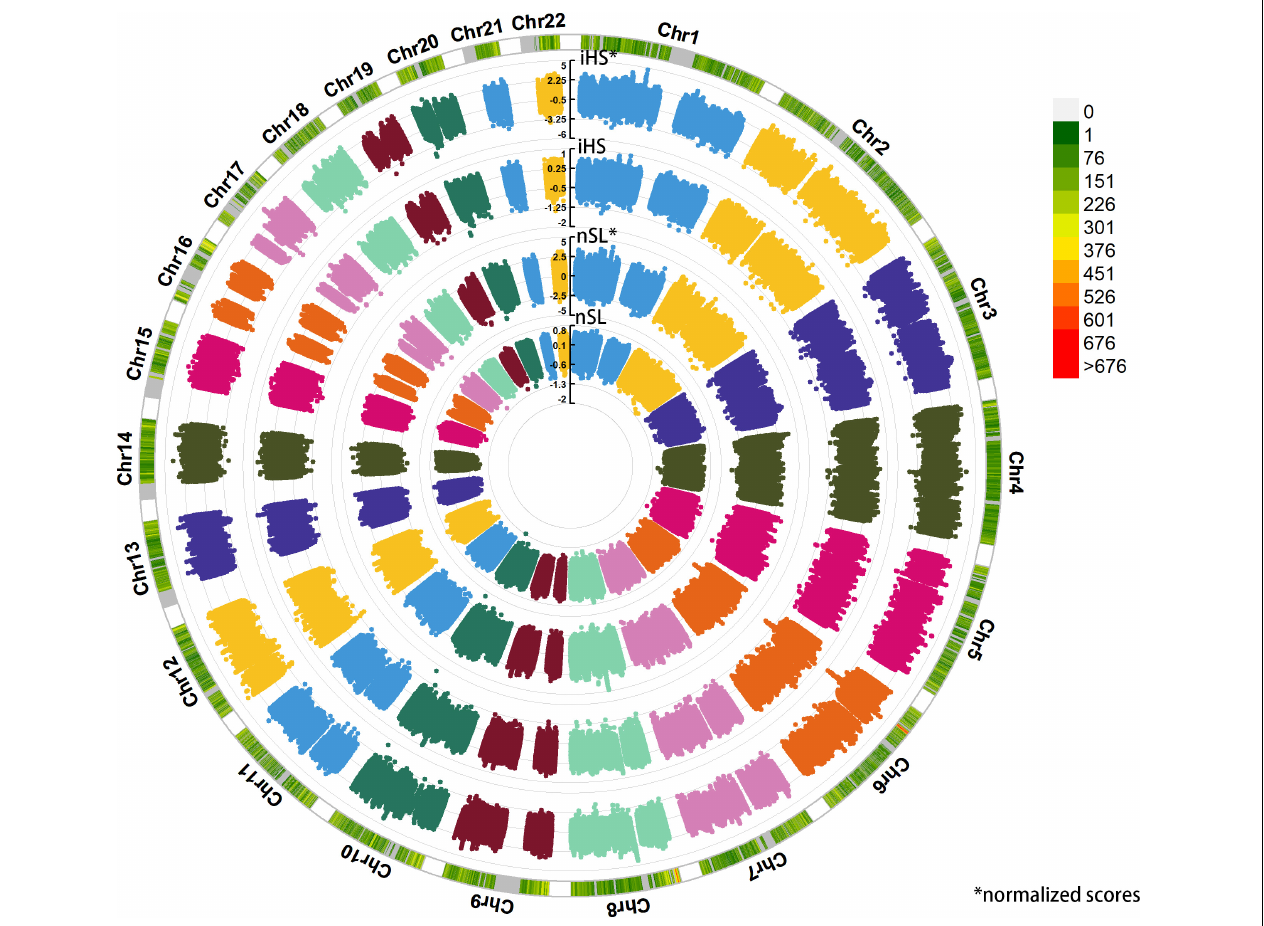
FIGURE 10 | Detecting the positive selection signals. Here, we displayed the raw iHS scores, standardized iHS scores, raw nSL scores, standardized nSL scores via circle Manhattan